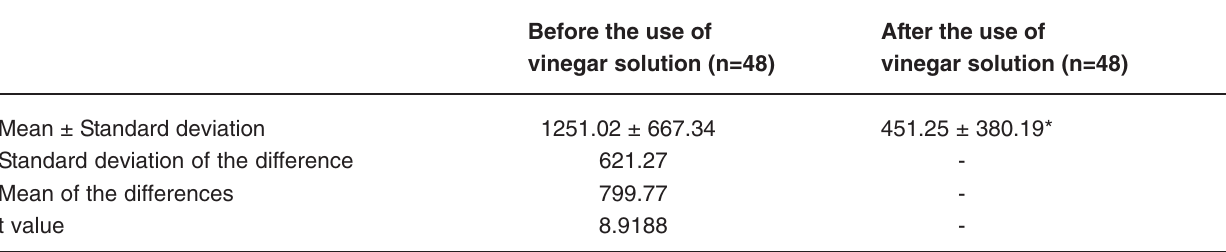
TABLE 1- Mean of cfu/mL and standard deviation of Candida genus yeasts, before and after the use of vinegar solution (Student’s t-test for paired samples)